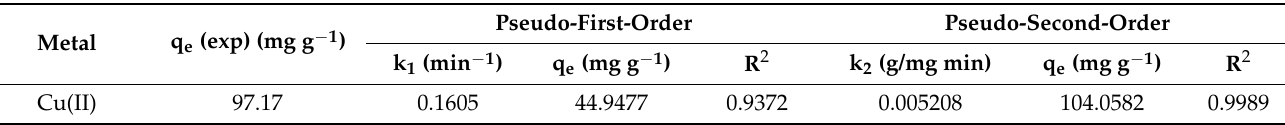
Figure 8. Effect of concentration on metal ion adsorption onto SiN-imd-py adsorbent. Adsorption conditions: m = 10 mg, V = 10 mL, [Cu(II)] = 10 to 300 mg L − 1 , pH = 6, time = 25 min at 25 ◦ C. Table 3. Kinetics models data of Cu(II)